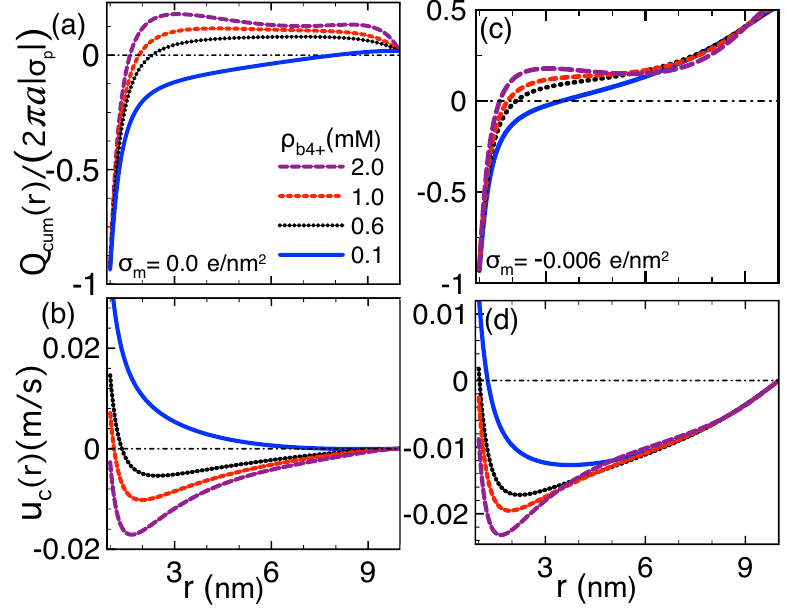
Figure 5. Rescaled cumulative charge density Q cum ( r ) / ( 2 π a | σ p | ) (top plots) and electrolyte velocity u c ( r ) (bottom plots) in ( a , b ) neutral and ( c , d ) weakly charged nanopores with fixed surface charge density σ m = − 0.006 e/nm 2 . The applied voltage is ∆ V = 120 mV, the nanopore length L m = 34 nm, and the monovalent counterion concentration ρ b + = 1 mM. The other parameters are the same as in Figure 4. The results are from Ref.